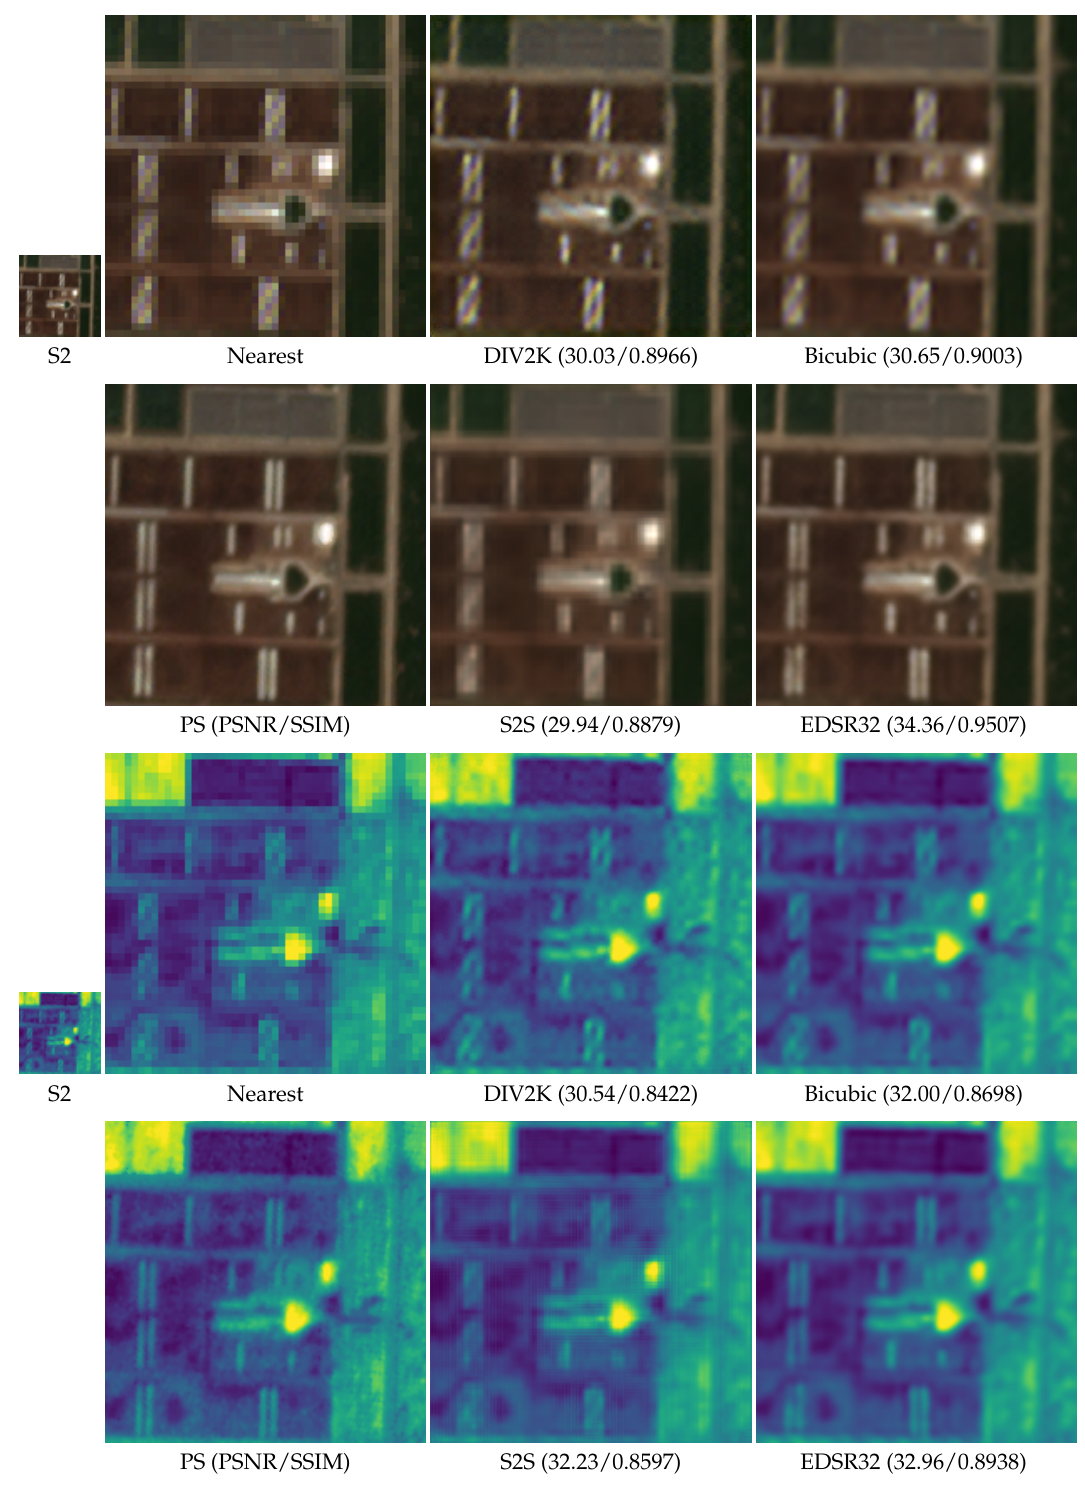
Figure 15. Visual comparison (RGB and NIR shown with viridis color palette) of the baseline and EDSR32 models (tiles from test